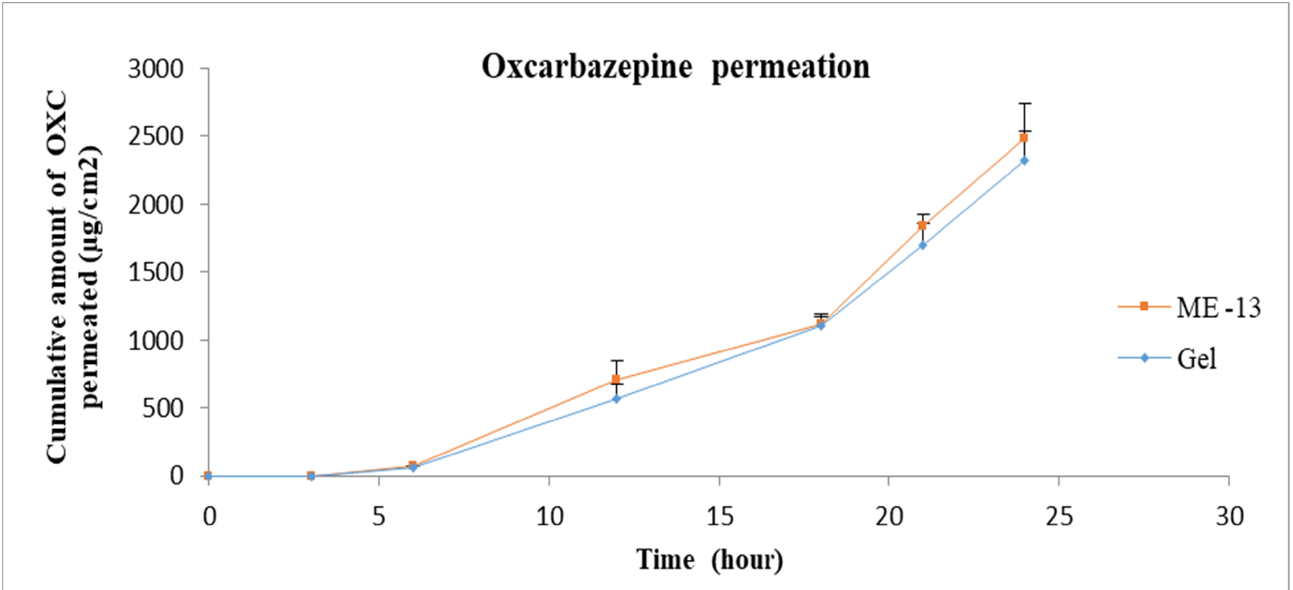
Figure 10. In vitro cumulative amount of OXC permeated per unit area versus time across the human cadaver skin. Each point represents the mean ± S.D. of three replicates in the absence of multiple